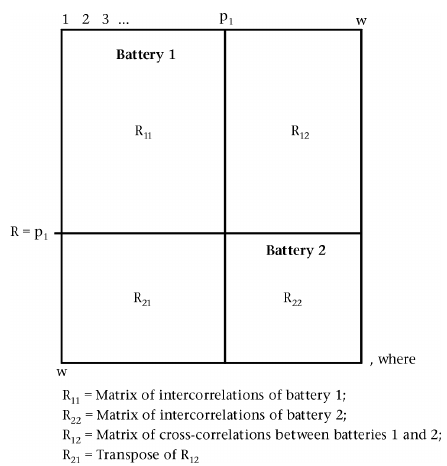
Figure 1: Super matrix